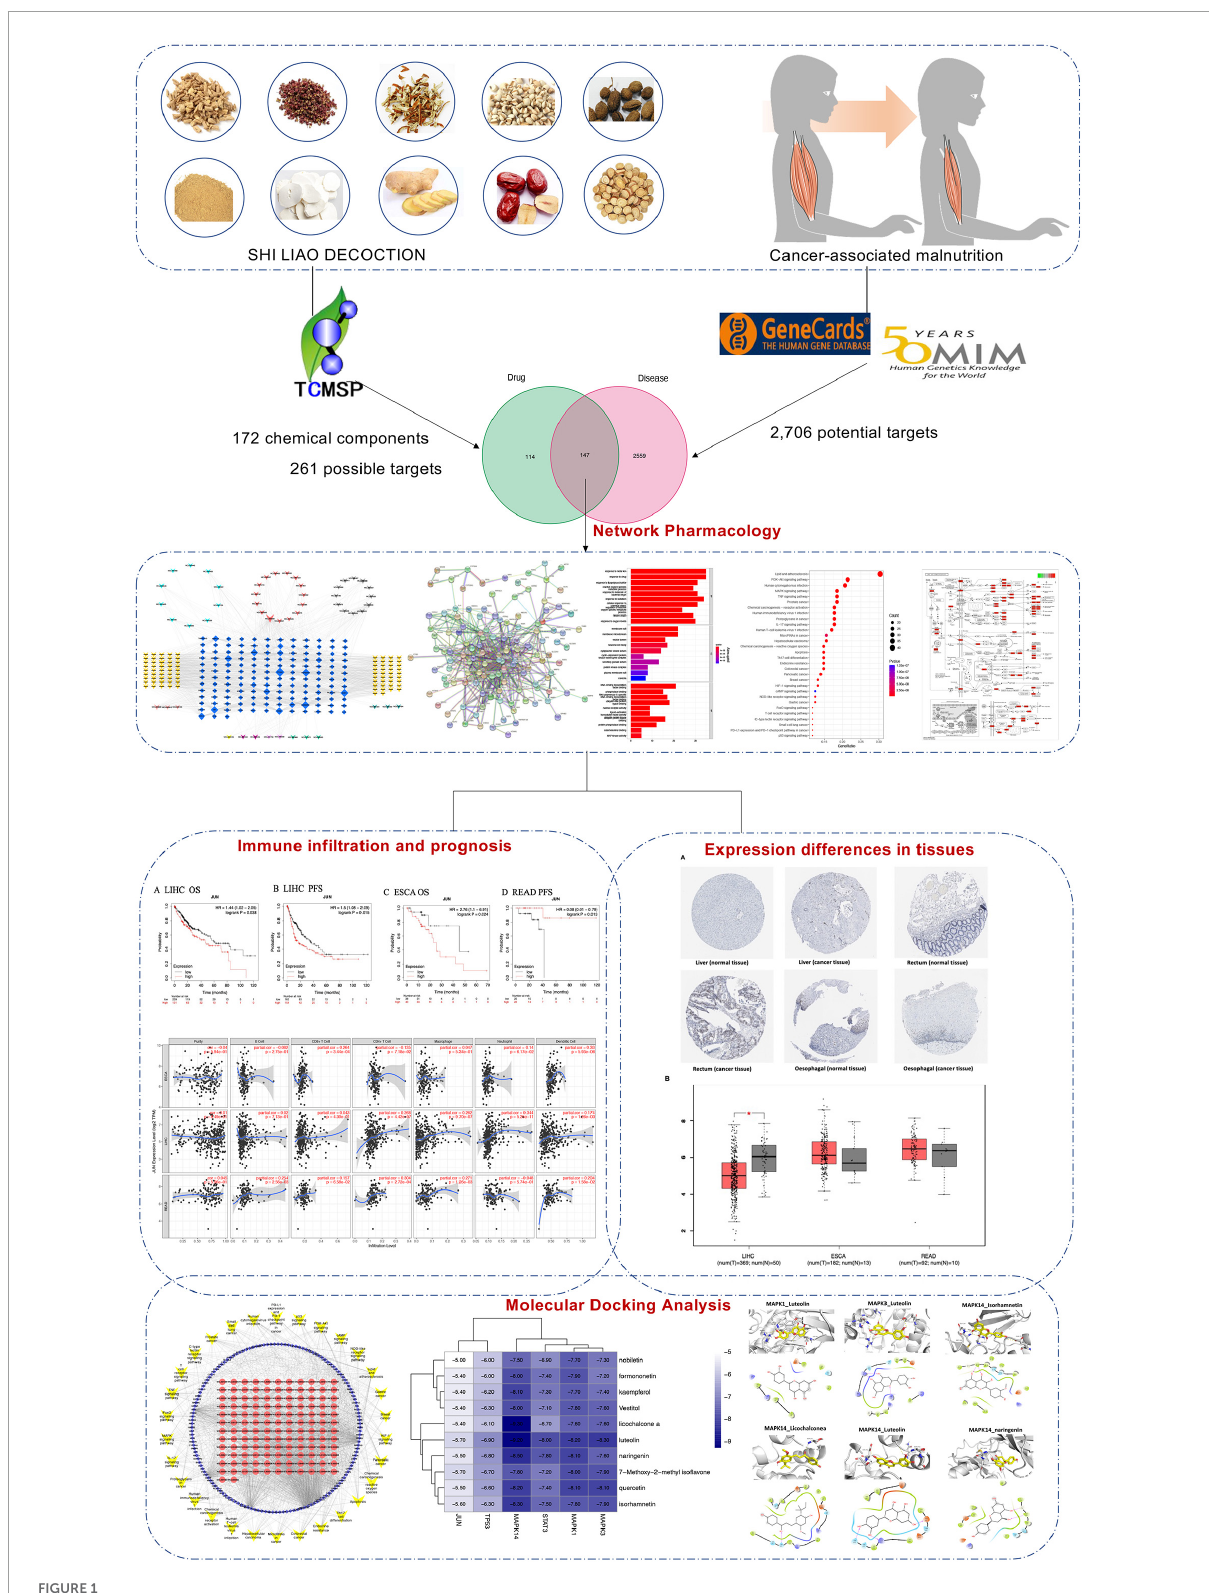
FIGURE1 Workflow diagram of network pharmacology